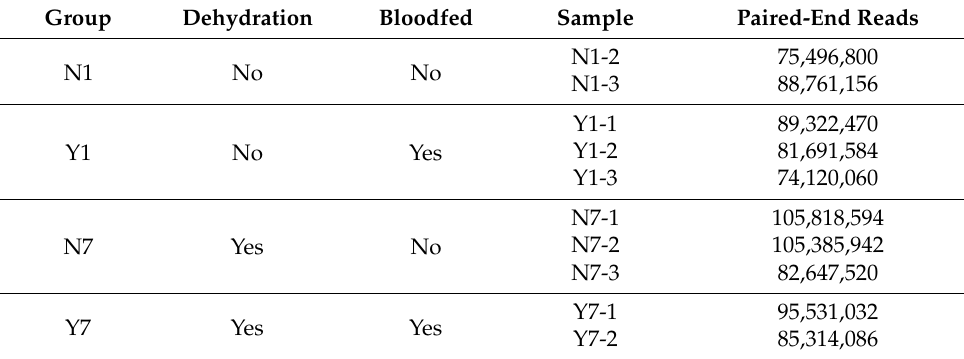
Table 1. Descriptive information regarding sample composition and read counts of experimental groups. Sample numbers are provided in the respective